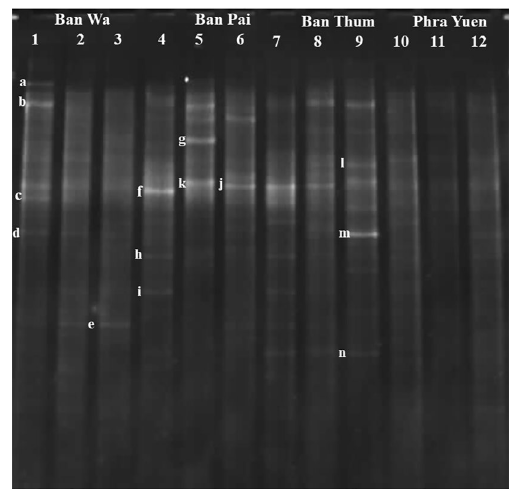
Figure 4. Denaturing gradient gel electrophoresis (DGGE) profiles of nested PCR products amplified from bacteria in the rhizosphere samples of genotype ‘RD 6’ rice planted in various saline fields. Three profiles of